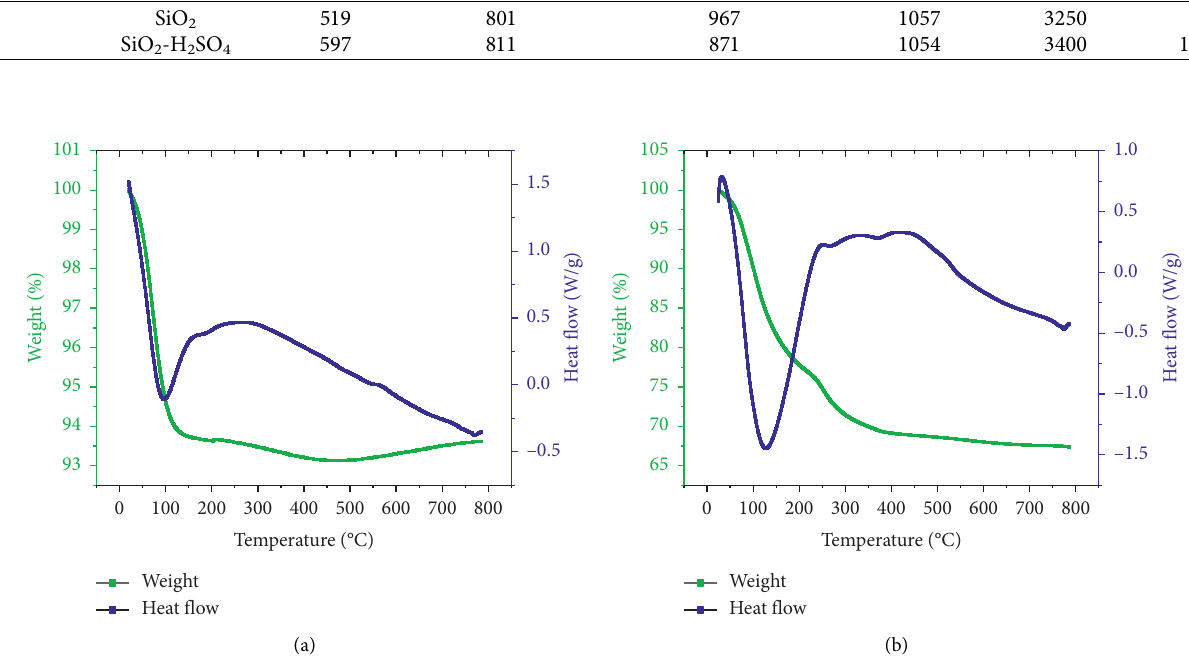
Figure 4: DSC and TGA profiles of (a) silica gel and (b) Si-H + catalyst.